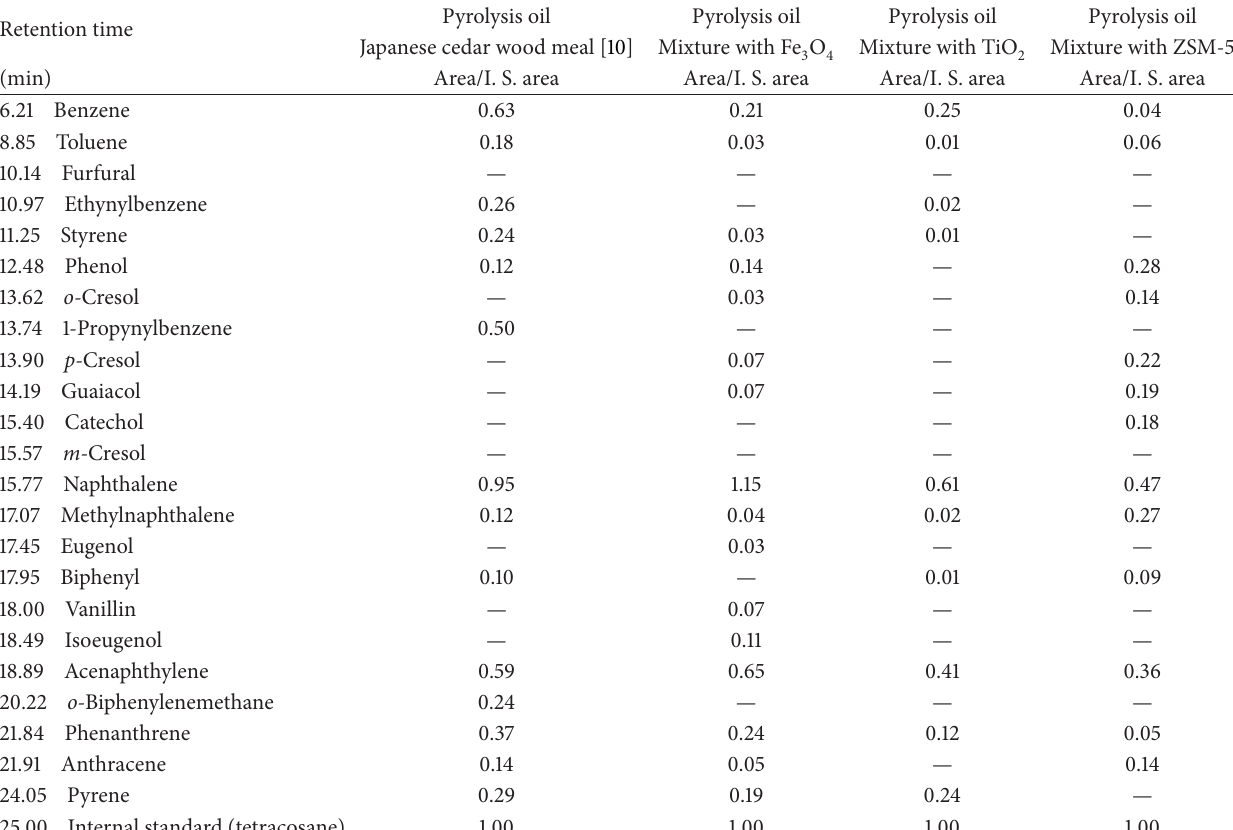
Table 2: GC-MS semiquantitative analysis of pyrolysis oil components obtained from Japanese cedar wood meal/catalyst (1: 1w/w) mixtures pyrolyzed at 800 ∘